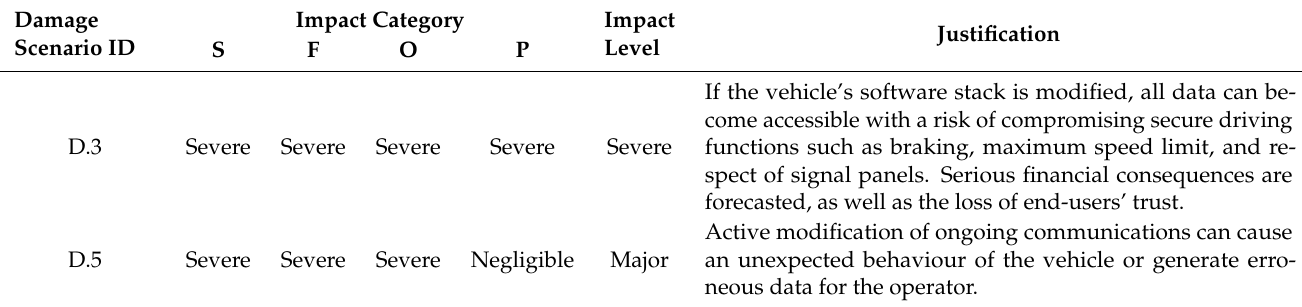
Table 2. Impact rating example for damage scenarios applicable to 3G/4G